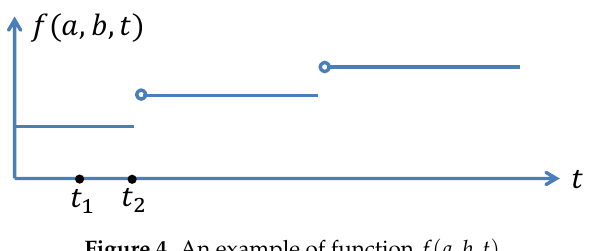
Figure 4. An example of function f ( a , b , t )